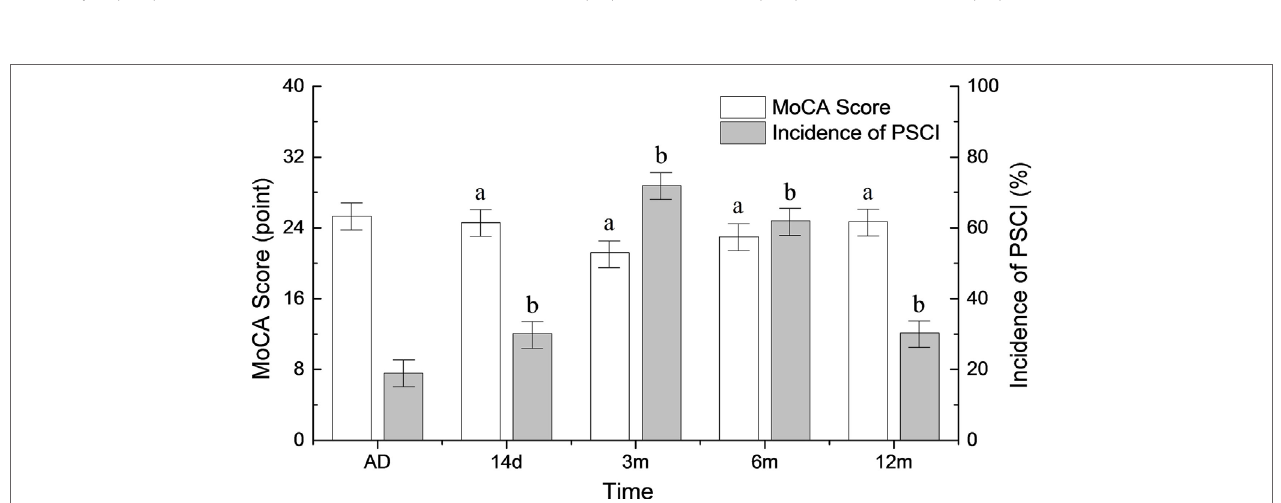
FigUre 1 | Changes in the incidence of poststroke cognitive impairment (PSCI) and MoCA scores during the follow-up period. AD, at admission. a p < 0.05 compared to MoCA score at admission. b p < 0.05 compared to PSCI at admission.